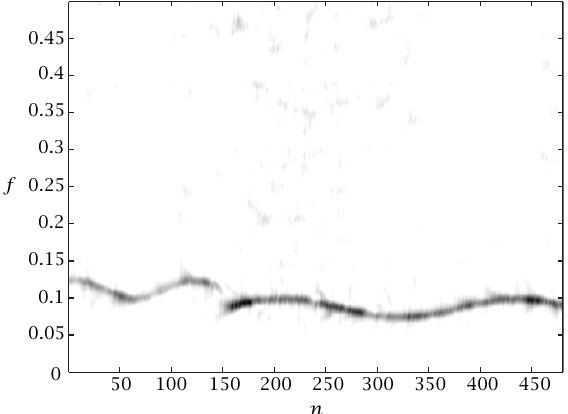
Figure 5: Time-frequency spectrum estimated when SNR = 2 . 5 dB. Notice the quality of the approximation,even if only 4 N events have been used ( N being the length of the numerical version of f(t) ).